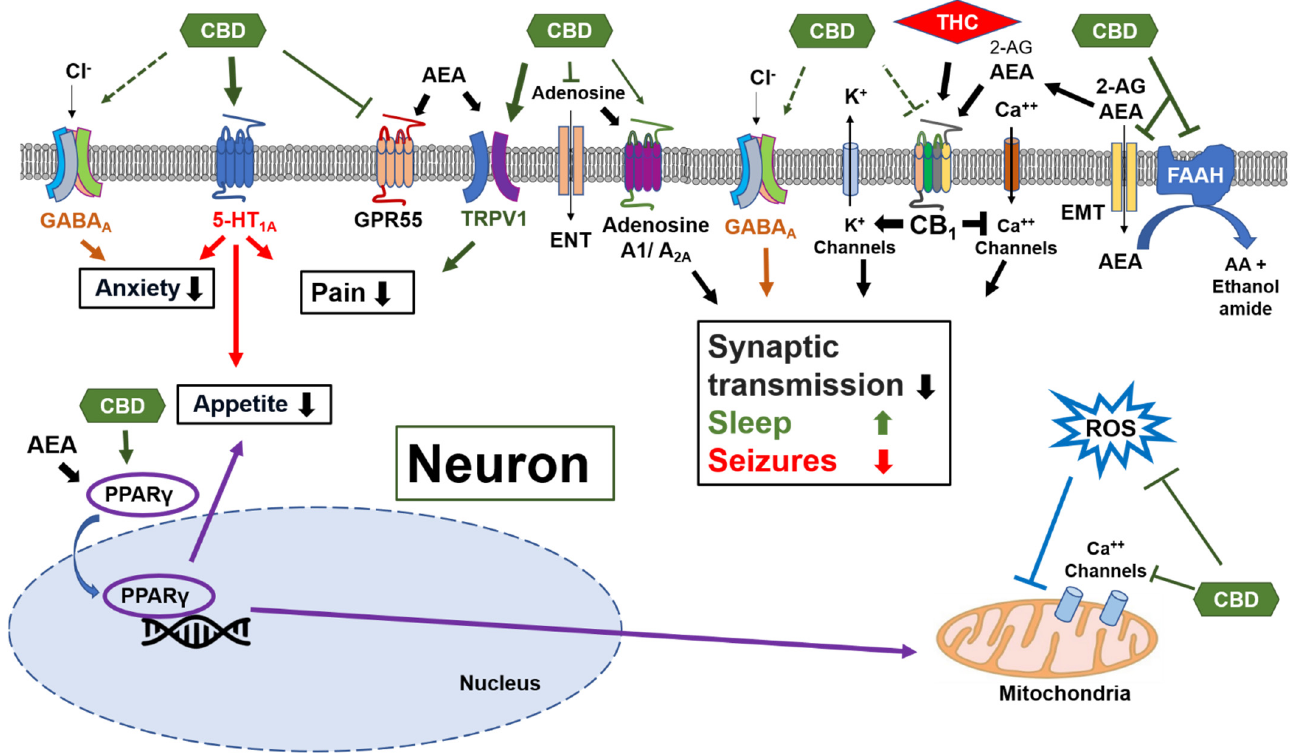
Figure 1. Multiple molecular targets for cannabidiol (CBD) in neurons . The main cannabinoid receptor in neurons is cannabinoid receptor type 1 (CB 1 R). The primary neuronal effect of the CB 1 R is a decrease in the synaptic transmission during increased synaptic activity, which can also promote sleep and reduce seizures and excitotoxicity. CBD is a negative allosteric modulator of the CB 1 R. However, CBD can activate the endocannabinoid system through the CB 1 R by inhibiting the endocannabinoid membrane transporter (EMT) and the degradation of anandamide (AEA) through fatty acid amide hydrolase (FAAH). This, in turn, increases the levels of the endocannabinoids AEA (main agonist of CB 1 R) and 2-Arachidonoylglycerol (2-AG). Other neuronal effects of CBD are mediated through agonism at the 5-HT 1A serotonin receptors and at the TRPV1 channel, reducing anxiety and pain, and through agonism of the nuclear PPAR γ receptors, increasing the expression of the cytoprotective enzymes. CBD also has direct antioxidative effects.